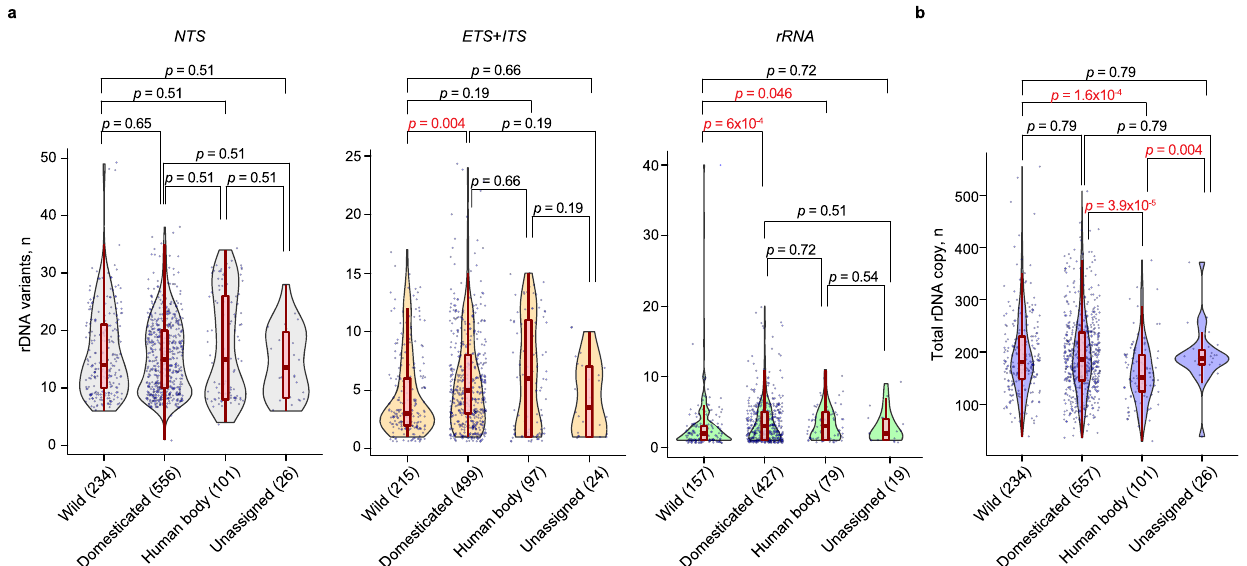
Fig. 2 | rDNA variation is strati fi ed by habitat. a Distribution of the number of rDNA variants across different habitats from ref. 34 grouped by rDNA element. Signi fi cance test: two-sided Wilcoxon rank-sum test adjusted for multiple hypoth- esis testing using the Benjamini – Hochberg correction. For ETS + ITS , wild vs domesticated: W = 45,070, p = 0.004, location shift = − 1, 95% con fi dence interval (CI)[ − 1,0].ForrRNA,wildvsdomesticated:W= 26,653, p = 6×10 − 4 ,locationshift= − 1, 95% CI [ − 1, − 6×10 − 5 ]; wild vs human body: W = 5038, p = 0.046, location shift = − 6.2×10 − 6 , 95% CI [ − 1, 0]. b Distribution of total rDNA copy numbers across the